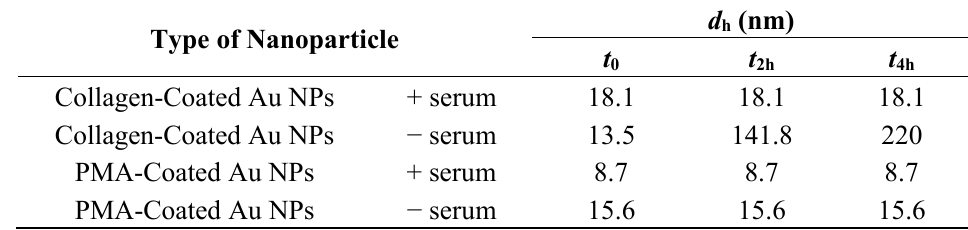
Table 1. Hydrodynamic diameter d h of Au NPs dispersed in cell culture medium with or without serum, t = 0 h ( i.e. , before), 2 h and 4 h after exposure to the medium. The concentration of Au NPs was c (NP) = 100 nM.